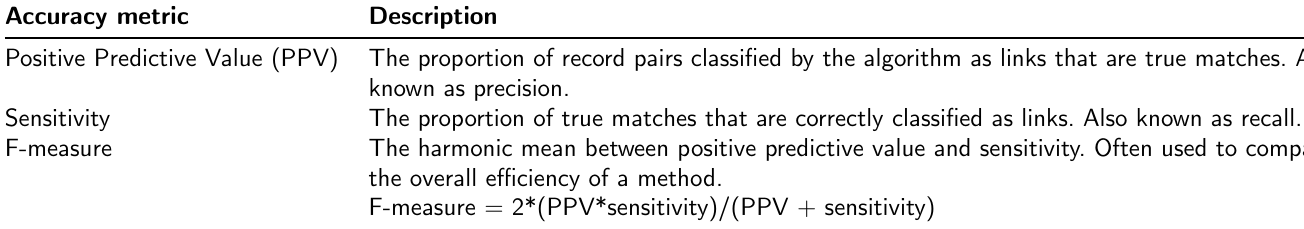
Table 4: Data linkage accuracy metrics (modified from GUILD